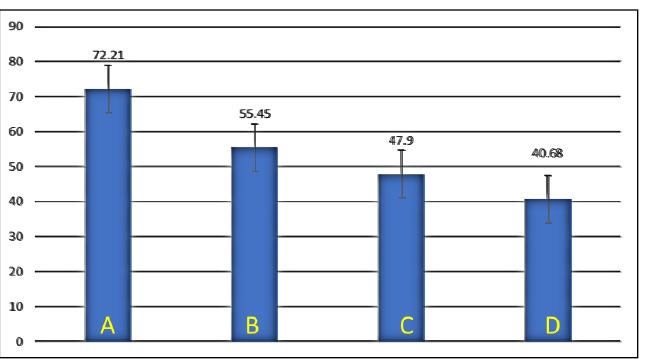
Figure 4. Mean values of fracture resistance in megapascals (MPa). A, Group A; B, Group B; C, Group C; D, Group D.